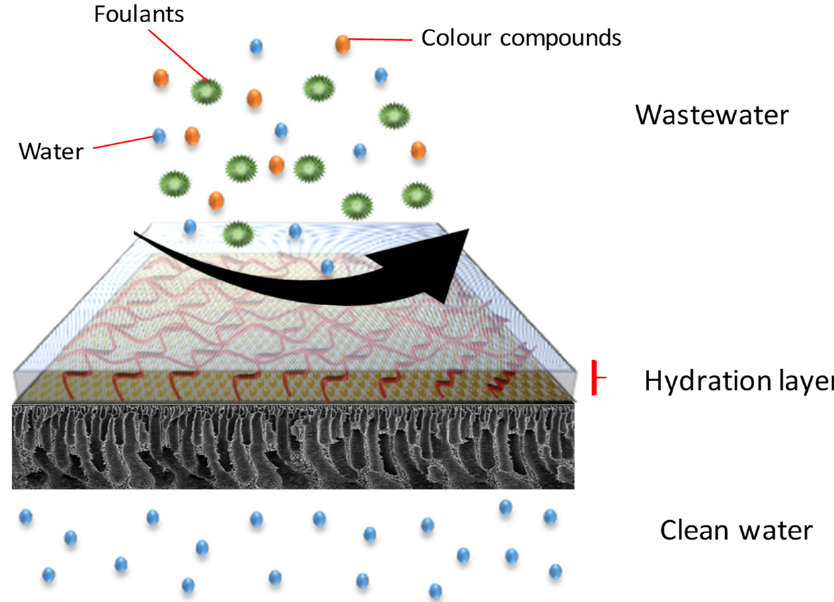
Figure 7 . Antifouling behaviour of DA/Z-PEI.